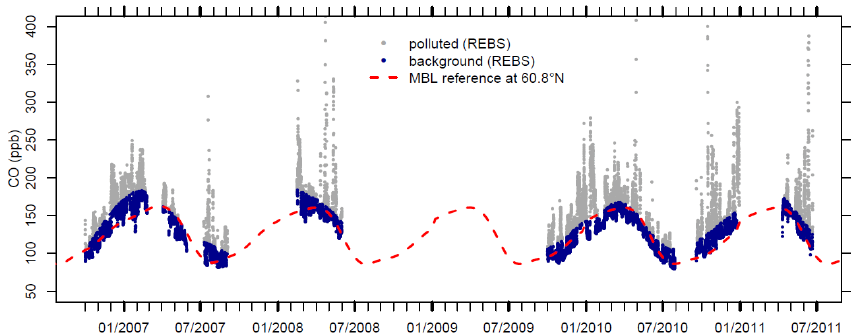
Figure 1: Time series of hourly mean CO concentration at ZOTTO. For reference, the background CO mixing ratio in the marine boundary layer representative of latitude 60.8 N is indicated by a red dashed line.